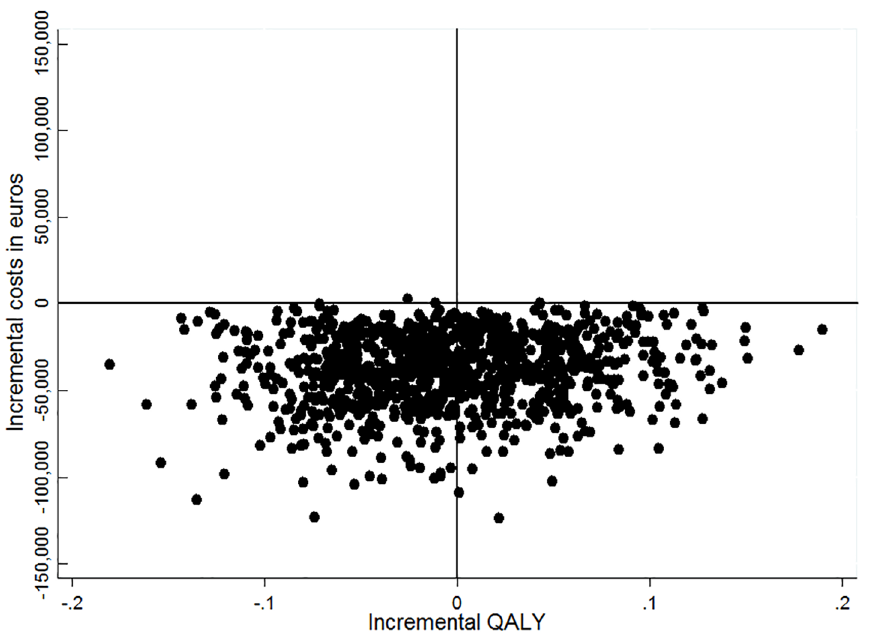
Fig 2. Cost-effectiveness plane. Cost-effectiveness plane for QALY of the person with dementia in the ICMM vs. control group.